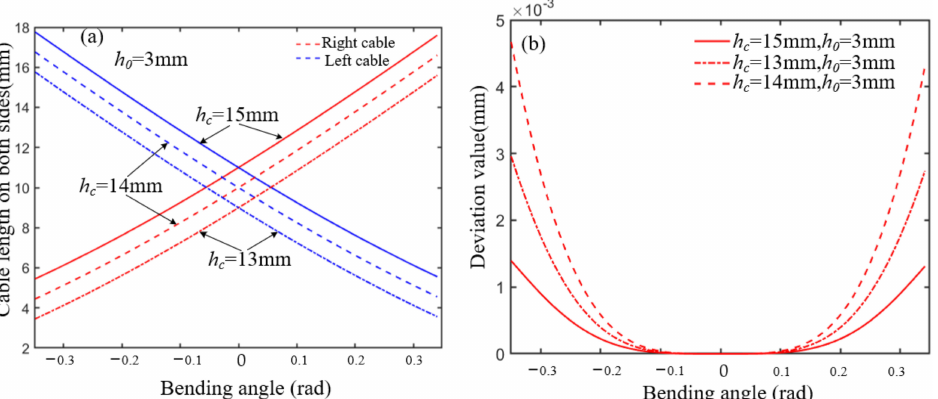
Figure 5. The cable length change on both sides and difference analysis. ( a ) The relationship between the h c and cable length on both sides. ( b ) The deviation value analysis between the h c and cable length in different h c .